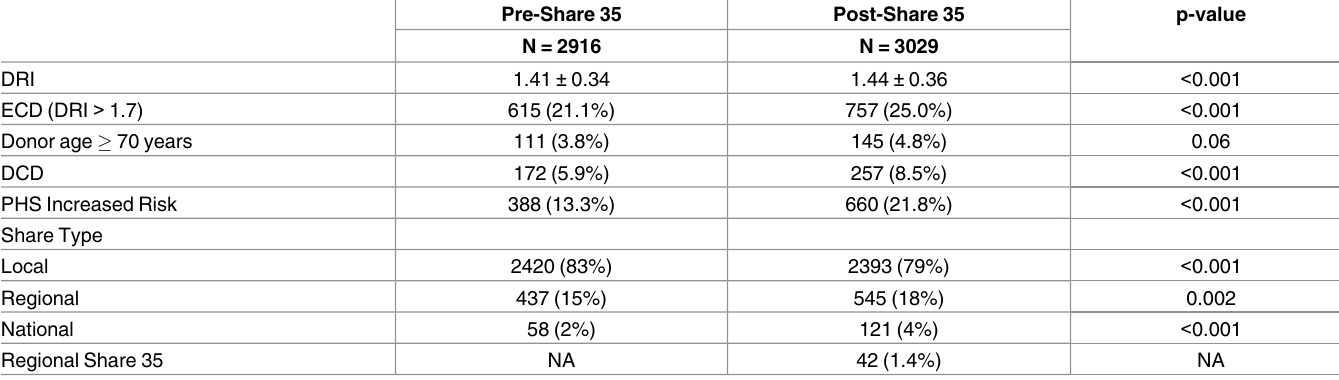
Pre-Share 35 Post-Share 35